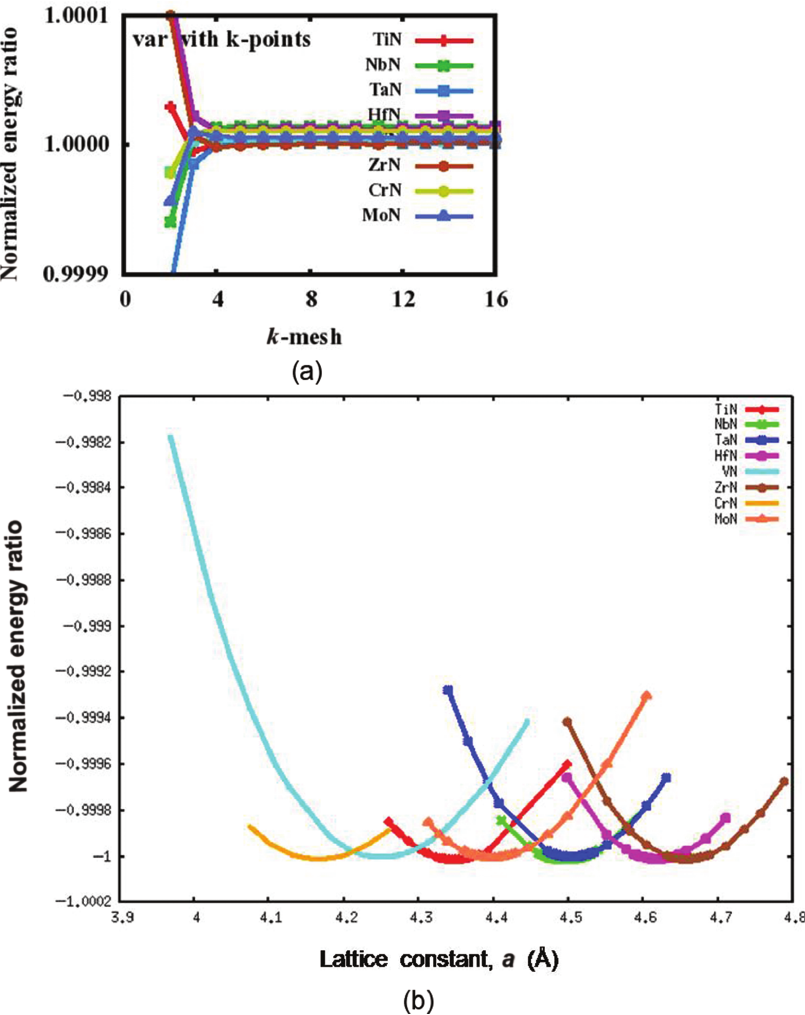
Figure 2: Variation of (a) k -mesh and (b) lattice parameter with normalized energy ratios for